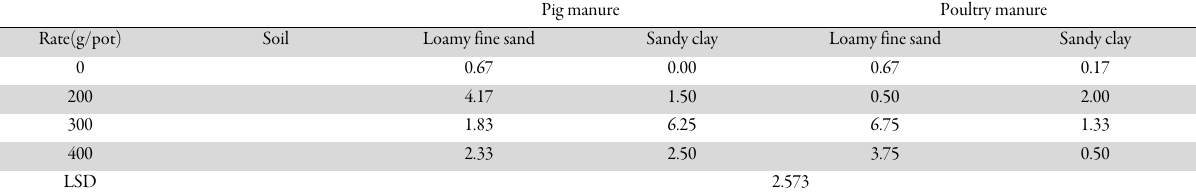
Table 8. Interaction between types and rates of manure and soil texture on number of small sized tubers of tiger nut at 20 cm soil depth. Values are a mean of 5 plants